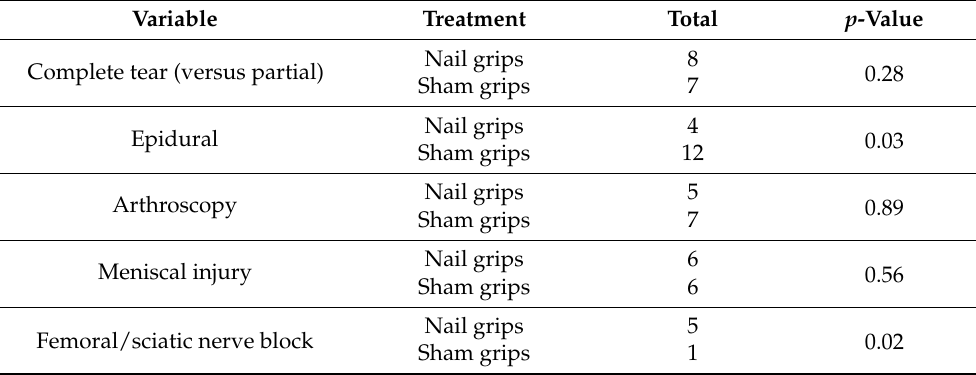
Table 2. Relative incidence of complete (versus partial) cranial cruciate ligament rupture, epidural, arthroscopy, meniscal injury, and femoral/sciatic nerve block in nail grips and sham grips groups. Variable Treatment Total p -Value Nail grips Complete tear (versus partial)